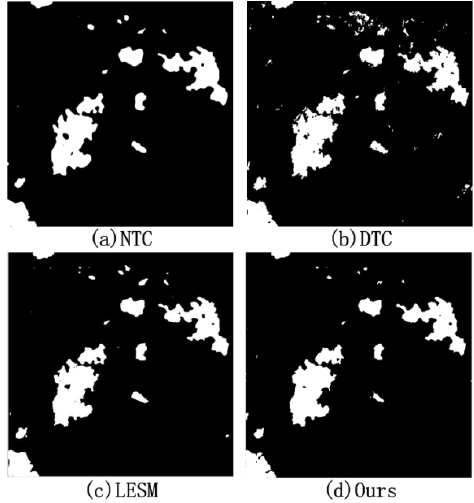
Figure 4: Visual comparison on Mexico dataset